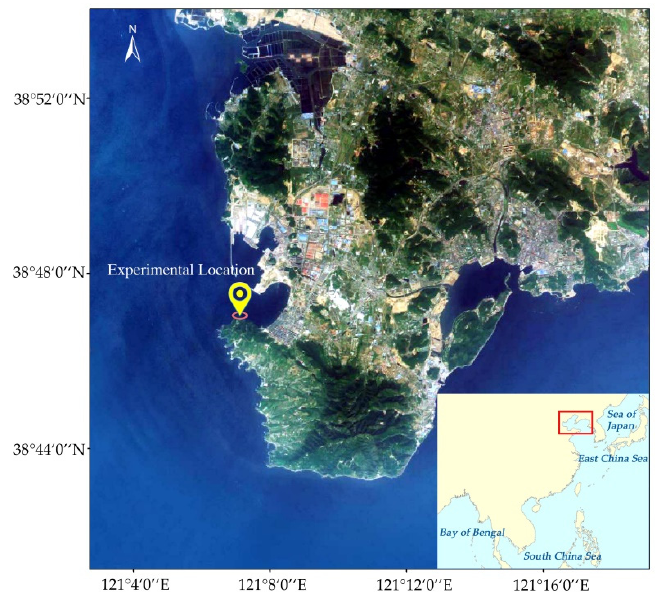
Figure 5. Location of the GNSS-R experiments (Dalian Lvshun, east China). The method was verified with four performance measures: the bias, root mean square error (RMSE), mean absolute percentage error (MAPE), and scatter index (SI), respectively, computed as